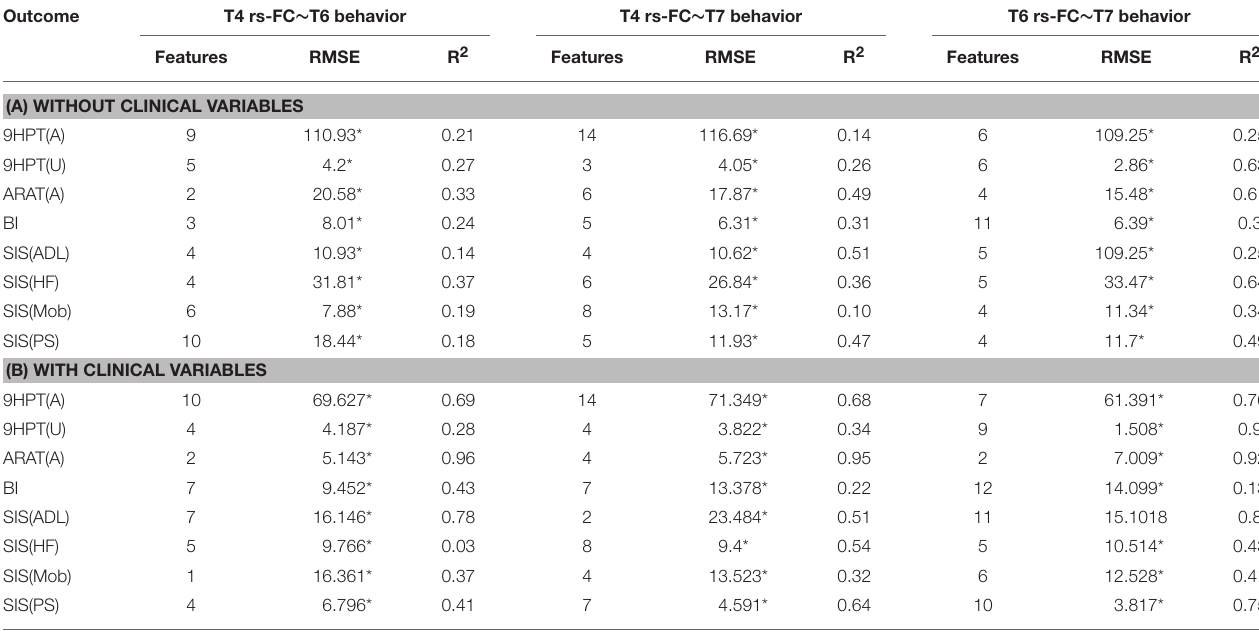
TABLE 4 | Linear-kernel SVR performances based on leave-one out cross-validation to correlate rs-FC at preceding time-point with behavioral measures at succeeding time-point are presented.